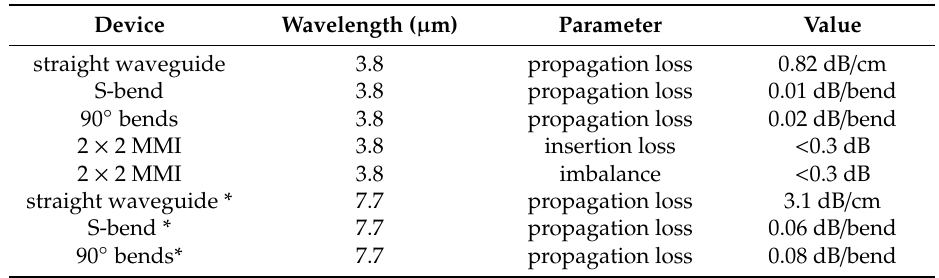
Table 6. Experimental performance of suspended Si photonic components, which will be available in the CORNERSTONE